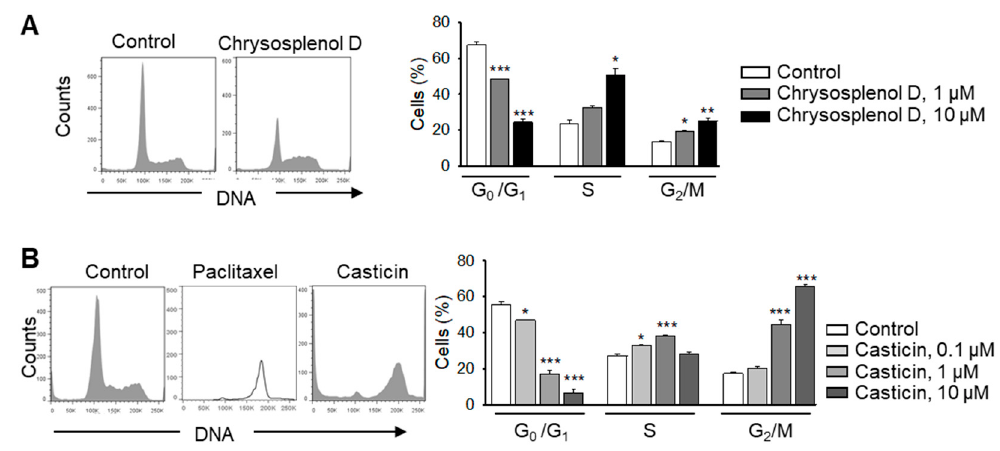
Figure 3. Chrysosplenol D and casticin induce cell-cycle aberrations in breast cancer cells. ( A ) MDA-MB-231 cells were treated with different concentrations of chrysosplenol D for 48 h, stained with propidium iodide, and analyzed by using flow cytometry. Representative histograms after treatment with chrysosplenol D (1 µM) are shown (left hand panel). Graph shows statistical analysis (right hand panel) ( B ) Cells were treated with different concentrations of casticin for 48 h and were analyzed as in ( A ). Concentrations were chosen on the basis of XTT assays showing cytotoxicity of casticin already at 1 µM. Representative histograms after treatment with casticin (1 µM, 48 h) and paclitaxel (100 nM, 24 h) are shown (left hand panel). Graph shows statistical analysis (right hand panel). Data are mean ± SEM, n = 3, * p < 0.05, ** p < 0.01, *** p < 0.001 vs controls. 2.4. Chrysosplenol D and Casticin Induce Apoptosis in Breast Cancer Cells Phosphatidylserine exposure, an early sign of apoptosis [15], was analyzed by annexin- V/propidium-iodide double staining. Cells treated with chrysosplenol D , casticin, or paclitaxel for 48 h exhibited increased numbers of annexin-V-positive and propidium-iodide-negative cells characteristic for early apoptotic cells (Figure 4A). A further, highly distinct late apoptotic feature is DNA condensation, fragmentation of the nucleus, and formation of apoptotic bodies [16]. Similar to paclitaxel, both compounds, chrysosplenol D and casticin, significantly increased the number of cells with hypodiploid DNA contents demonstrating DNA fragmentation and formation of apoptotic bodies (Figure 4B). The number of cells with fragmented DNA (Figure 4B) after treatment with chrysosplenol D and casticin D correlates well with the number of late apoptotic, double annexin- V/propidium-iodide-positive cells (Figure 4A).